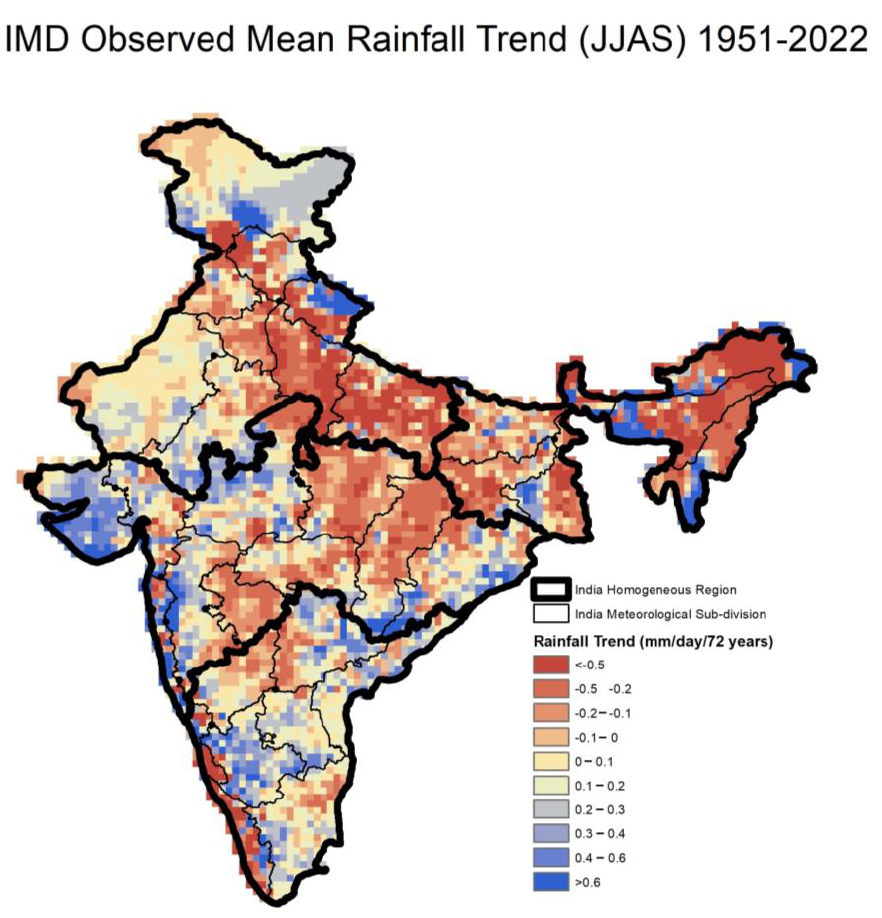
Figure 5. India Meteorological Department (IMD) Observed Mean Rainfall (June to September) Trend 1951 – 2022.